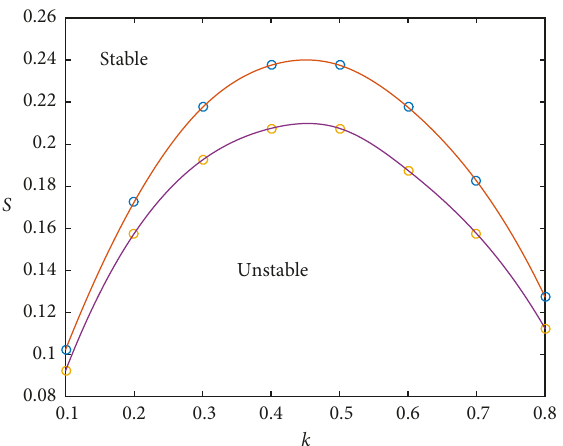
c versus β for the case